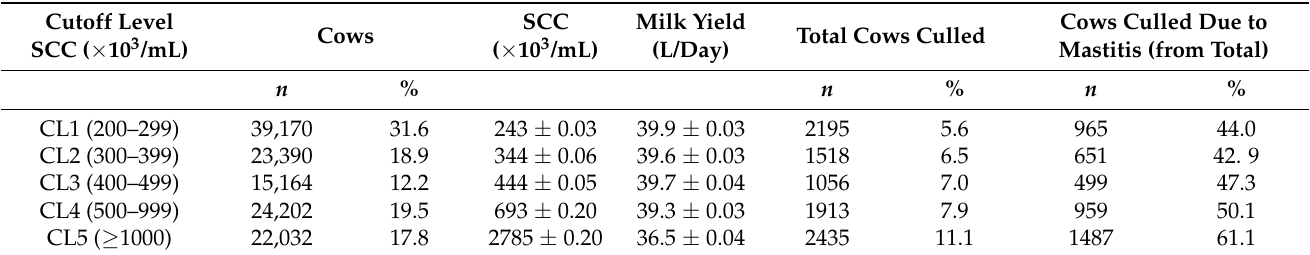
Table 1. The five independent analyses based on somatic cell count (SCC)-cutoff levels of number of cows and percent of total in 2018 ( n = 958,123), average and SE of SCC and milk yield at time of first SCC elevation, and number of cows culled and percent of total number of cows culled due to mastitis and overall per cutoff group.